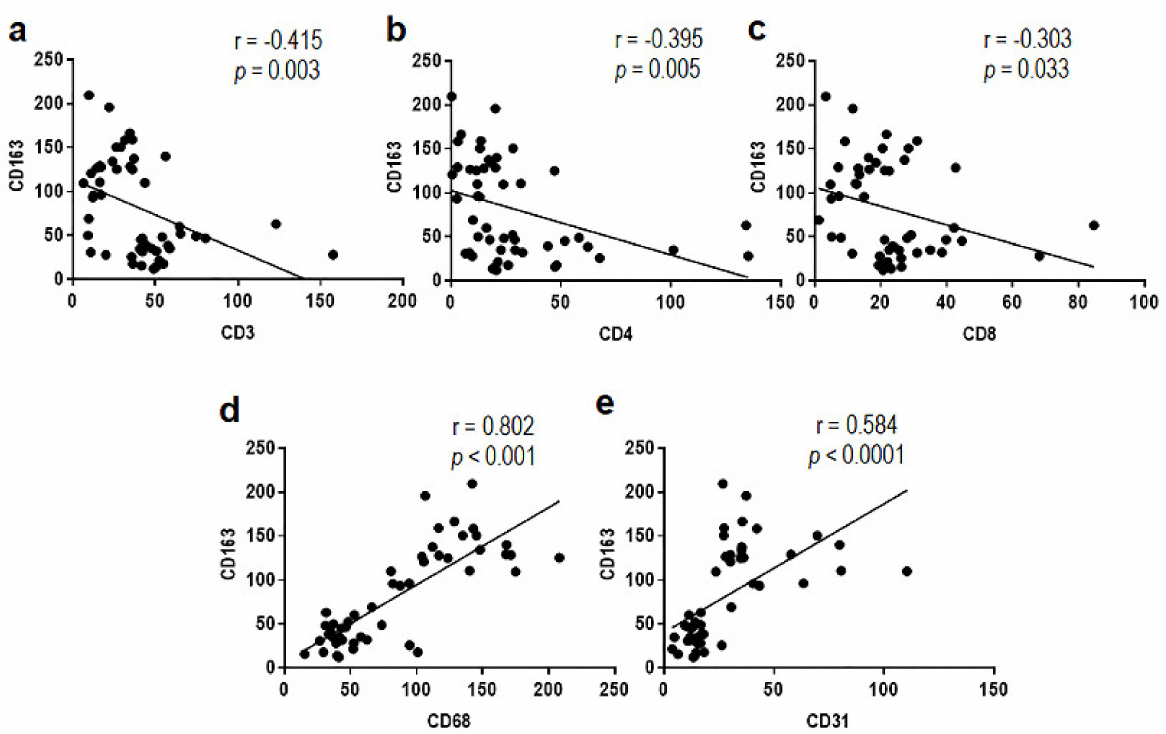
Figure 3. Pearson correlation between the average count of CD163+ macrophages and ( a ) CD3+ T lymphocytes, ( b ) CD4+ T helper lymphocytes, ( c ) CD8+ cytotoxic lymphocytes, ( d ) CD68+ macrophages, and ( e ) CD31+ microvessels in 50 MLPS tissue sections. Pearson correlation coefficients (r) are